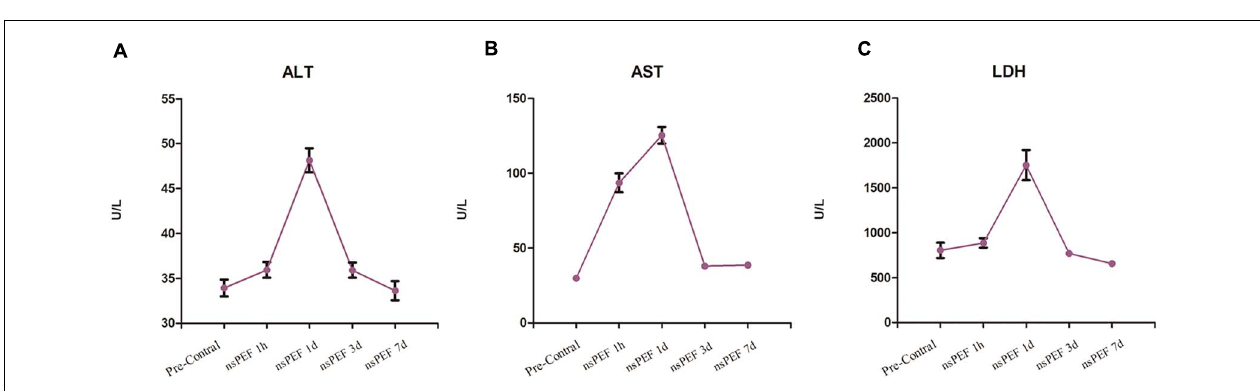
FIGURE 2 | Liver function. The tested liver function results included alanine aminotransferase (ALT; A ), aspartate aminotransferase (AST; B ) and lactate dehydrogenase (LDH; C ). The blood samples for each pig were collected at 1 h pre-treatment and at 1 h, 1 day, 3 days, and 7 days